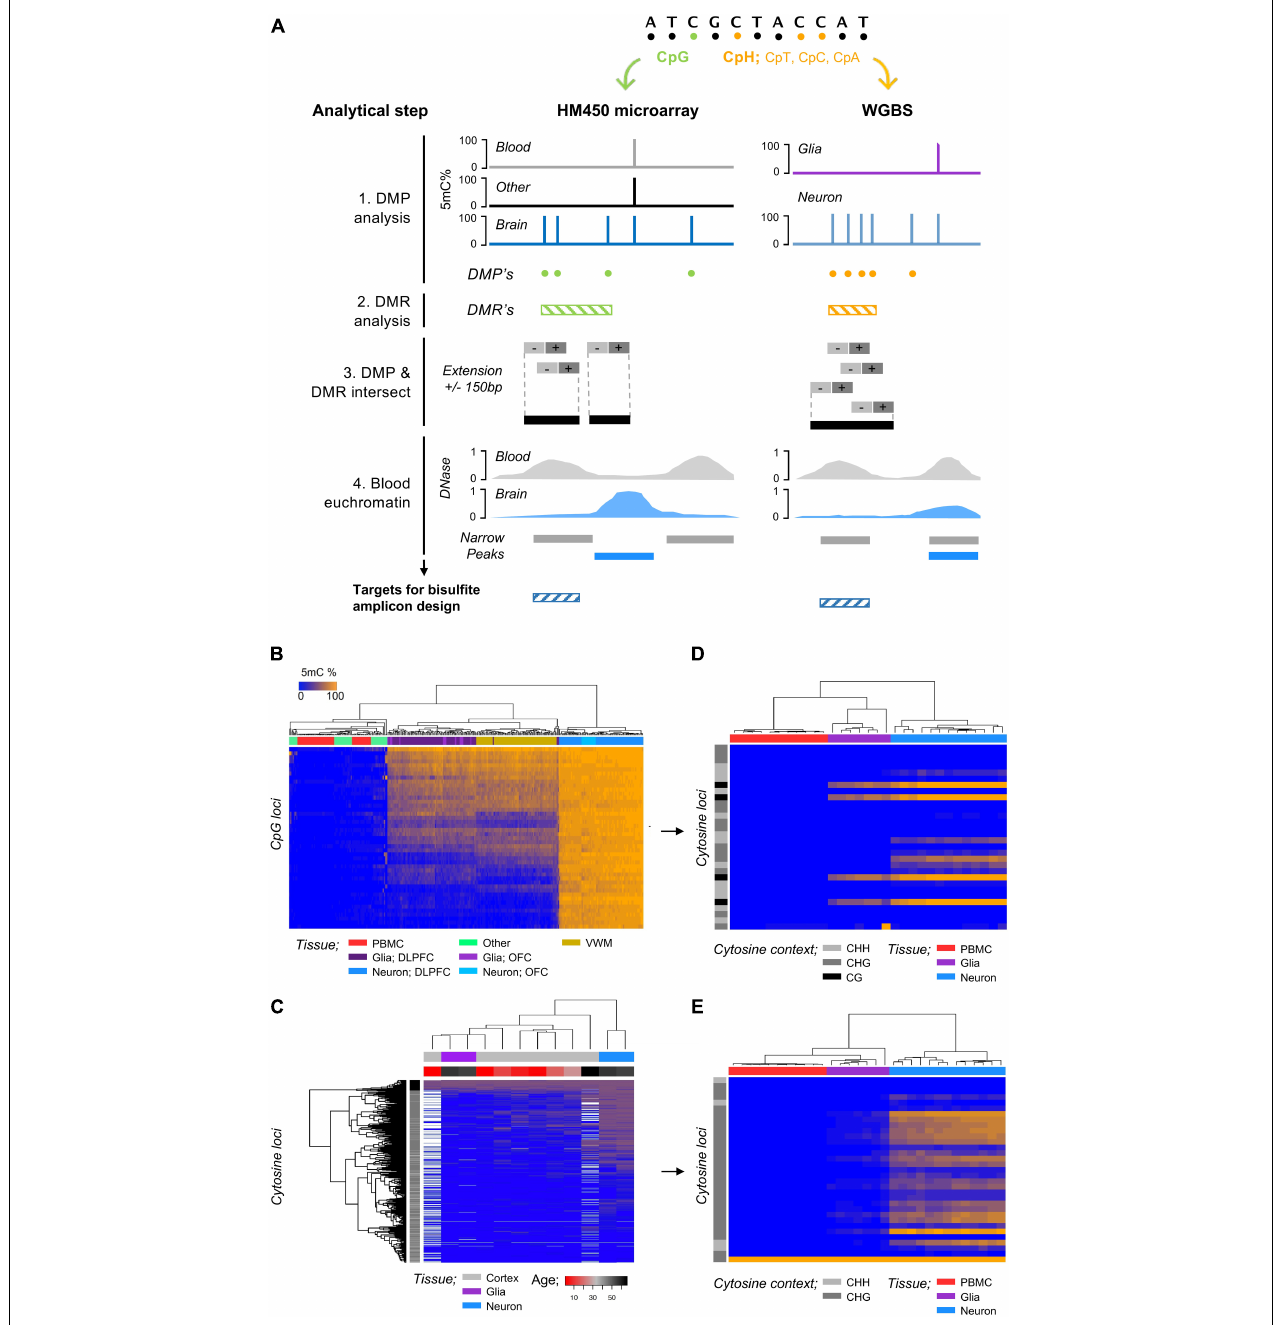
FIGURE 1 | Discovery and validation of regions of the genome that harbor glia and neuron DNA methylation (5mC). (A) Strategy for characterization of genomic region/cytosine loci selection for glia and neuron cfDNA methylation analysis. (1) DMPs were identified by linear regression between glia/neurons (brain cells) and blood cells and other tissues of the human body, (2) DMRs were identified by bumphunter analysis between brain cells, blood cells, and other tissues, and (3) brain-cell DMP and DMRs were intersected (GenomicRanges) to refine DMPs within genomic regions with DNA methylation specific to a brain cells. The DMPs were extended ± 150 bp for assay design, and (4) target genomic regions for bisulfite amplicon design were refined to euchromatic regions of blood cells and heterochromatic regions of brain cells. (B) Heatmap shows unsupervised hierarchical clustering of samples by cell-type using the DNA methylation (CpG microarray) of 45 CpG found hypermethylated within neurons compared to blood ( > 90%) and “other” cells/tissue types ( > 80%). DLPFC, dorsolateral prefrontal cortex; OFC, occipital frontal cortex; VWM, ventral white matter. (C) Heatmap shows unsupervised hierarchical clustering of samples by cell-type (neuron/glia) and developmental age (cortex; gray matter) using the DNA methylation (WGBS; Lister et al., 2013) of 741 cytosine loci within 28 regions found within “high-density” regions of hypermethylated CpH within neurons. (D) Heatmap shows unsupervised hierarchical clustering of samples by cell-type using the DNA methylation of CpG and CpH loci following bisulfite amplicon sequencing. (E) Heatmap shows unsupervised hierarchical clustering of samples by cell-type using the DNA methylation of CpH loci following bisulfite amplicon sequencing.